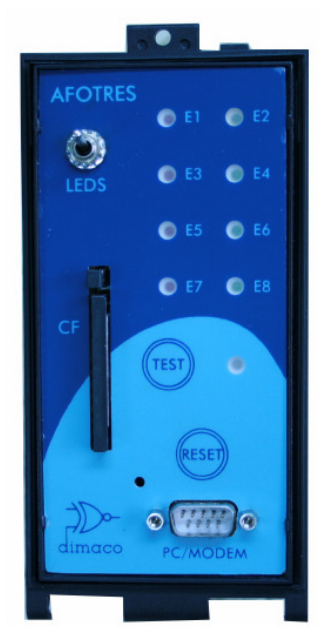
Figure 2. Eight-loop vehicle inductive detector